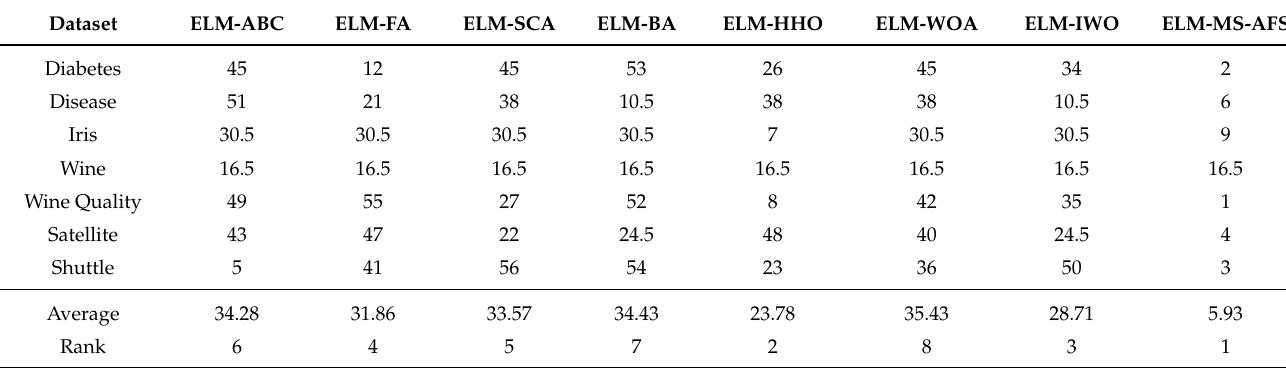
Table 8. Friedman Aligned test ranks for the compared